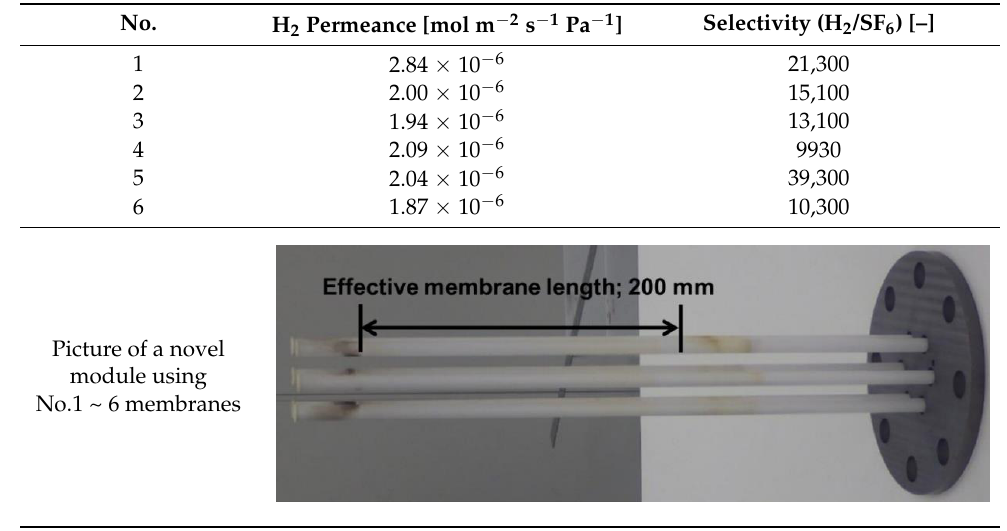
Table 2. Hydrogen permselective performances of our previous silica membranes for MCH dehydrogenation.